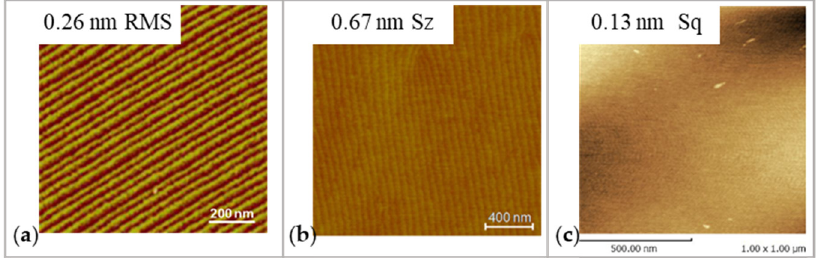
Figure 11. The AFM images of PAP-processed workpiece: ( a ) SiC. Reproduced with permission from [97]; ( b ) GaN. Reproduced with permission from [99]; ( c ) SCD. Reproduced with permission from [100].